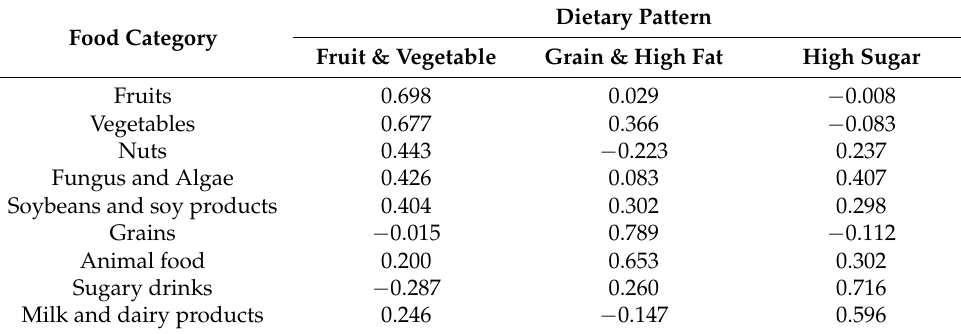
Table 3. Factor loadings of the food category for the three dietary patterns.